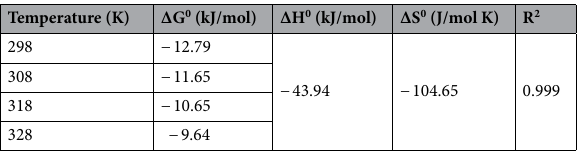
Table 3. Thermodynamic parameters of MB adsorption using Fe 3 O 4 @Void@m.SiO 2 .